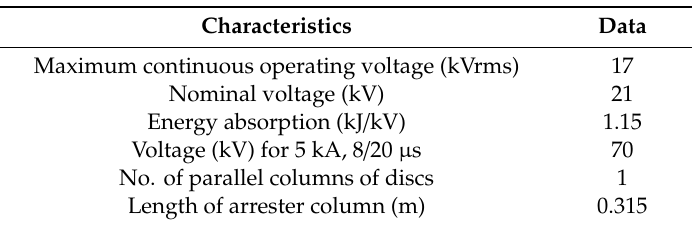
Table 3. Arrester characteristics.